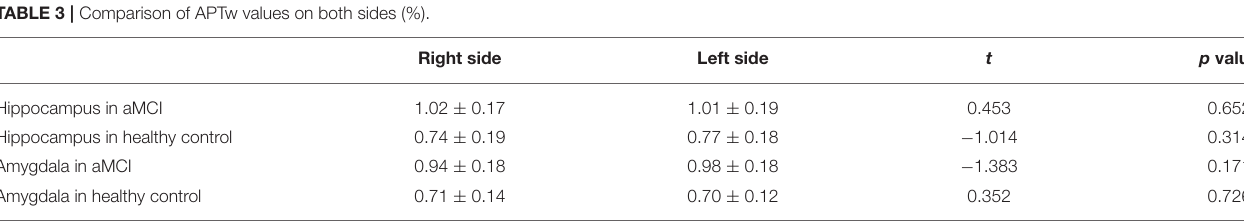
TABLE 3 | Comparison of APTw values on both sides (%). Right side Left side p